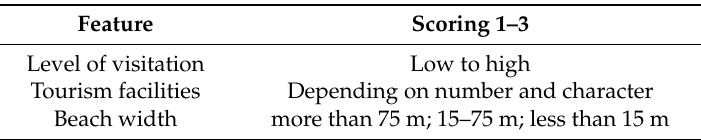
Table 8. Assessment of beach vulnerability in regard to